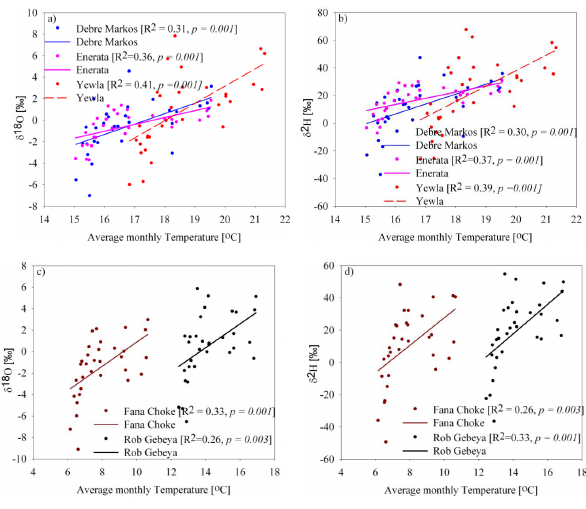
Figure 6. Relationships between amount-weighted isotopic com- Fig. 6. Relationships between amount weighted isotopic composition of precipitation samples position of precipitation samples at different stations with monthly at different stations with monthly average air temperature over the investigation period. average air temperature over the investigation period.